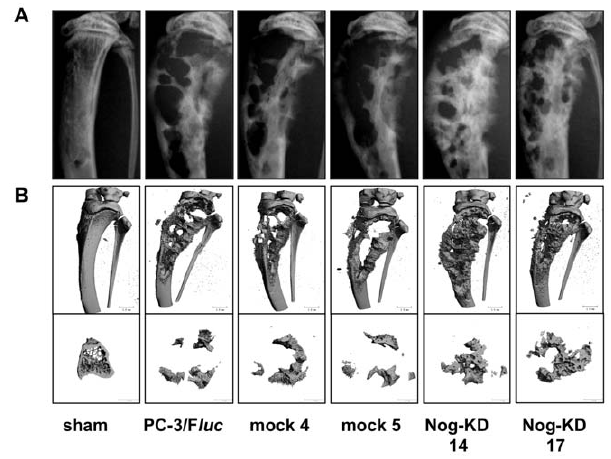
Figure 3. Noggin silencing promotes increase in radiodensity and partial bone repair in advanced osteolytic lesions. A . Representative images of radiography and B . 3-D reconstruction ( m -CT) of tibiae (top) and of 1 mm thick cross sections (bottom) of sham- operated and cancer cell-xenografted tibiae at day 25 after intra- osseous inoculation.